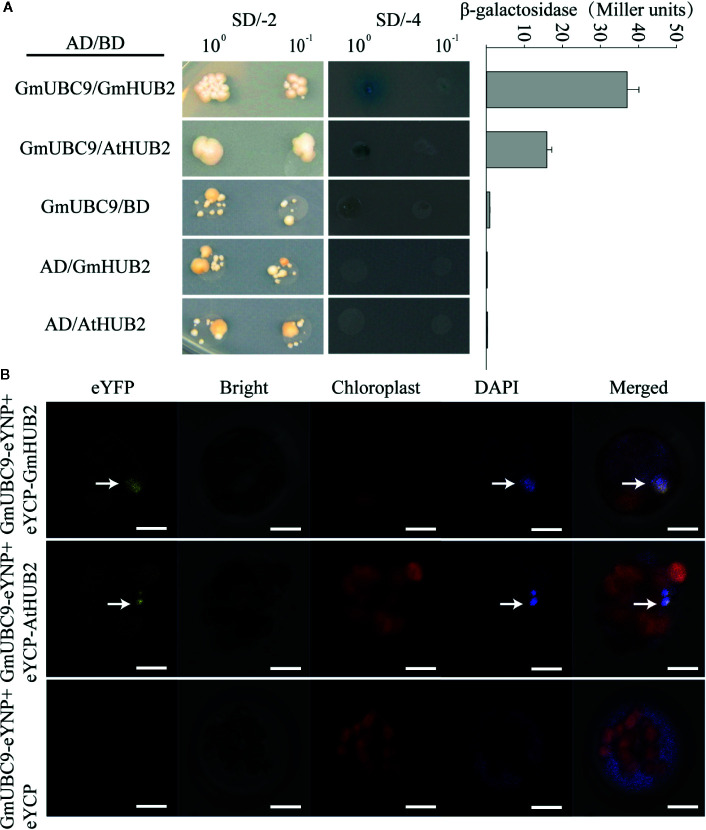
GmUBC9 interacts with GmHUB2/AtHUB2. (A) Interaction between GmUBC9 and GmHUB2/AtHUB2 detected by yeast two-hybrid (Y2H) assays and a quantitative assay for β-galactosidase activity. The presented values are the averages of four independent assays with standard deviations. pGADT7 (AD) and pGBKT7 (BD) were used as negative controls. AD, GAL4 activation domain. BD, GAL4 DNA-binding domain. (B) Confirmation of the interaction of GmUBC9 and GmHUB2/AtHUB2 by BiFC in Arabidopsis protoplasts. DAPI was used to stain nuclei. The white arrow indicates the nucleus. Scale bars, 10 μm.